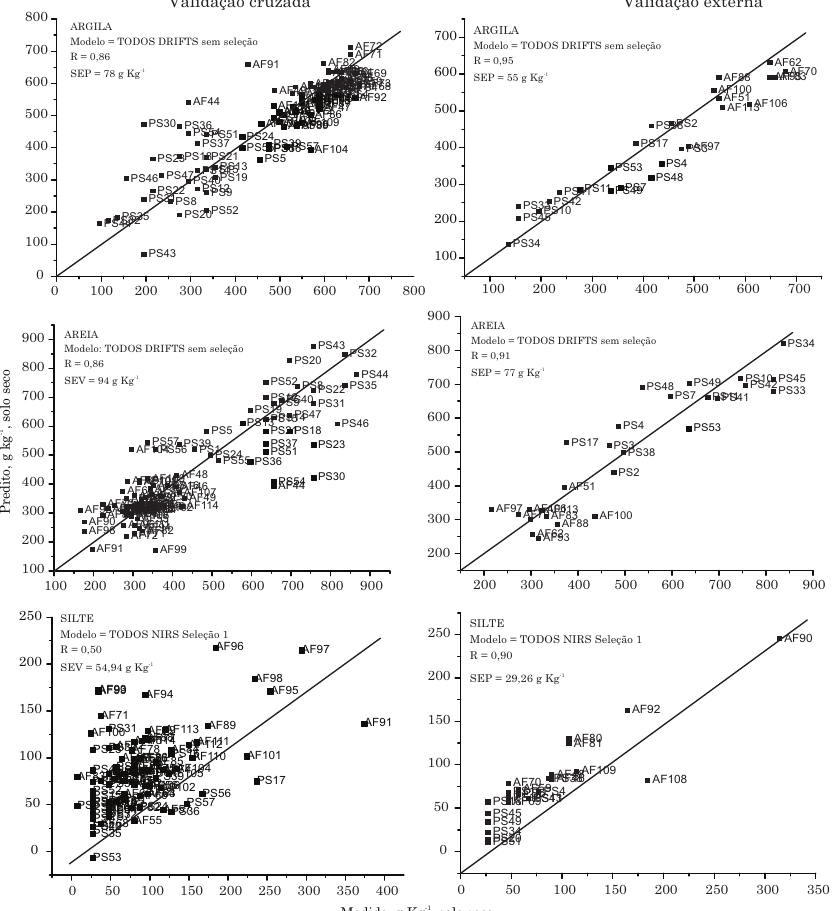
Figura 3. Valores preditos pela espectroscopia de infravermelho versus valores medidos pelo densímetro para argila, silte e areia. Linha diagonal indica situação ideal onde valores preditos são iguais aos